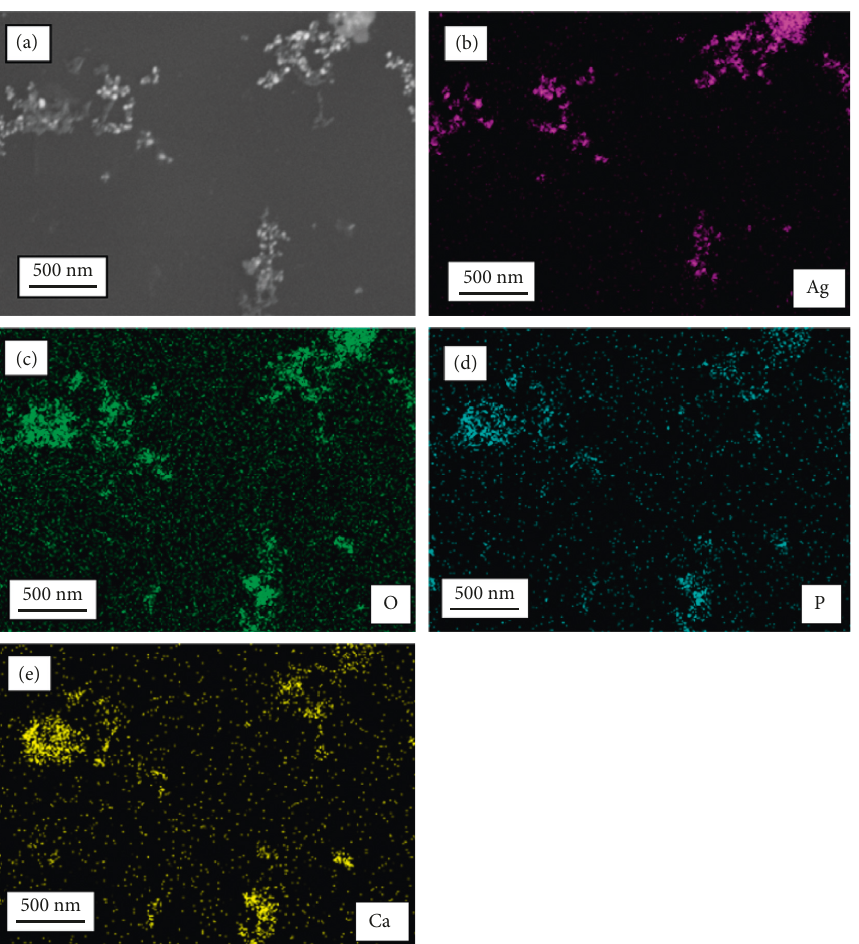
Figure 6: (a) SEM image of a TEM grid containing the coprecipitated Ag and HAp. EDS elemental maps: (b) Ag, (c) O, (d) P, and (e) Ca of the Ag-HAp